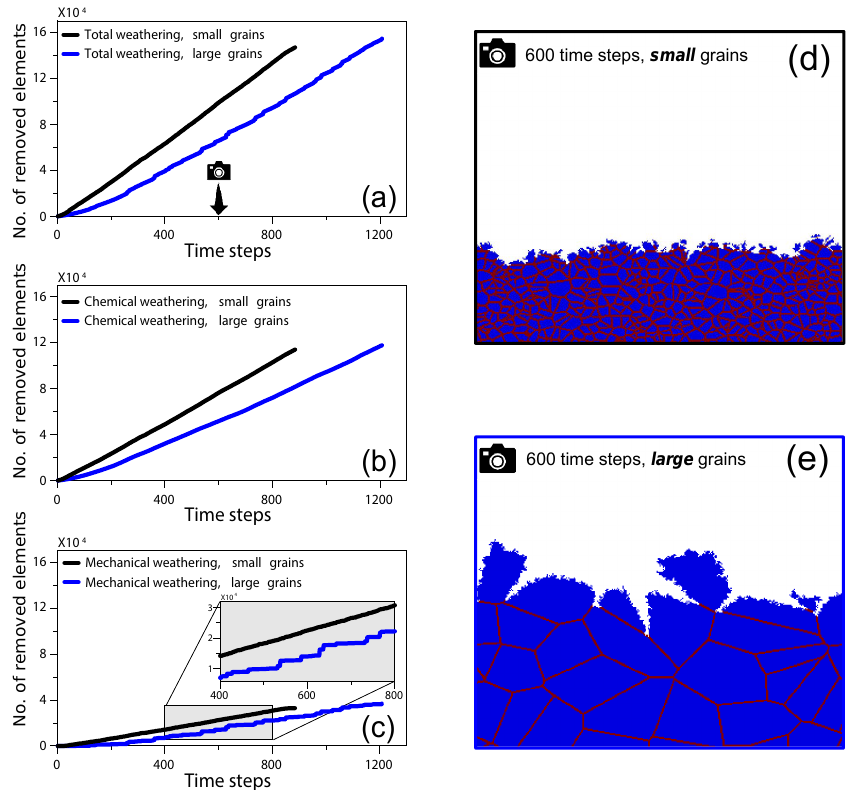
Figure 2. Number of removed elements as a function of time steps for two different simulations. Elements removed by (a) total weathering, (b) chemical weathering, and (c) mechanical weathering. The black lines represent the simulation with small grains (relative grain size = 2), while the blue lines represent the number of removed elements in the simulation with the large grains (relative grain size = 64). The camera icon in (a) indicates the timing of the snapshots for the (d) small-grain simulation and (e) the large grain simulation. The domain is comprised entirely of high-reactivity grains. For both grain sizes, chemical weathering contributes more to the total weathering than mechanical weath- ering. In the fine-grained rock (d) , 67% of the material has been removed; by contrast, in the snapshot from the coarse-grained rock (e) , taken after the same number of time steps, only 42% of the rock has been removed. The coarse-grained rock has a 7% density of grain boundaries, while in the fine-grained rock the boundaries cover 39% of the simulated rock area. The higher density of reactive grain boundaries seen in the fine-grained rock promotes the increased rate of